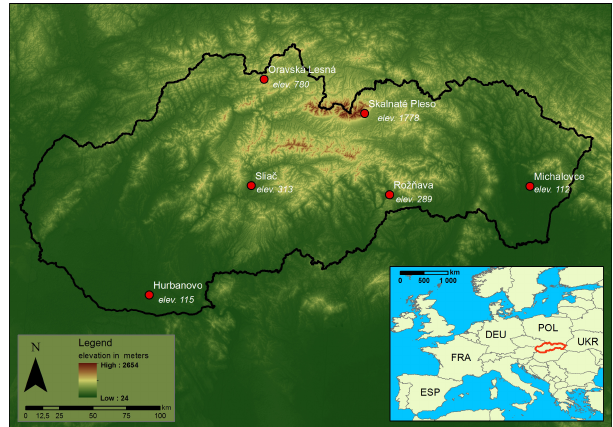
Figure 1. Location of the meteorological stations used in the study.